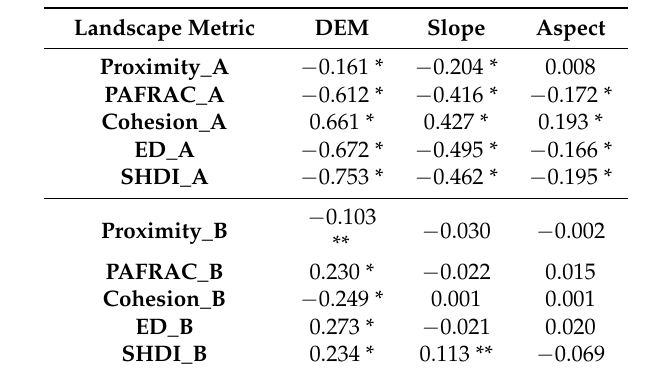
Table 2. The correlation coefficients between landscape metrics and topography factors (* p < 0.01, ** p < 0.05).